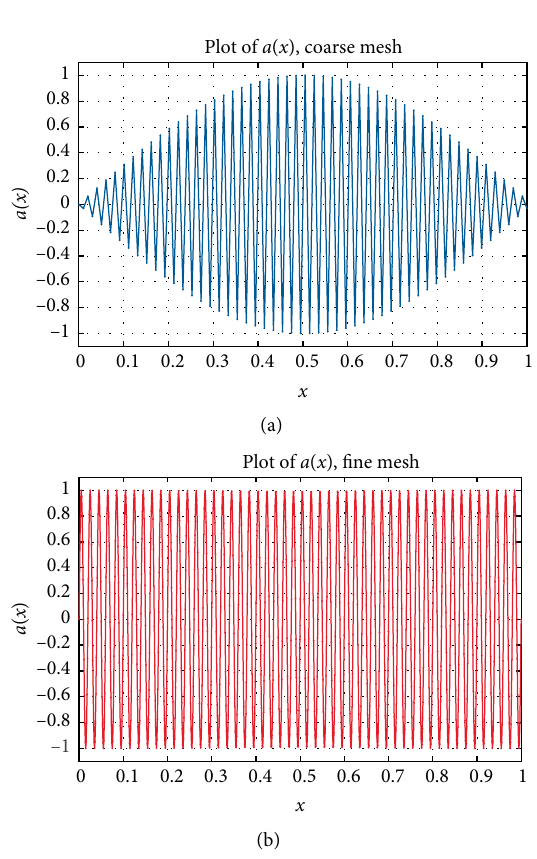
Figure 1: Diffusion parameter mesh